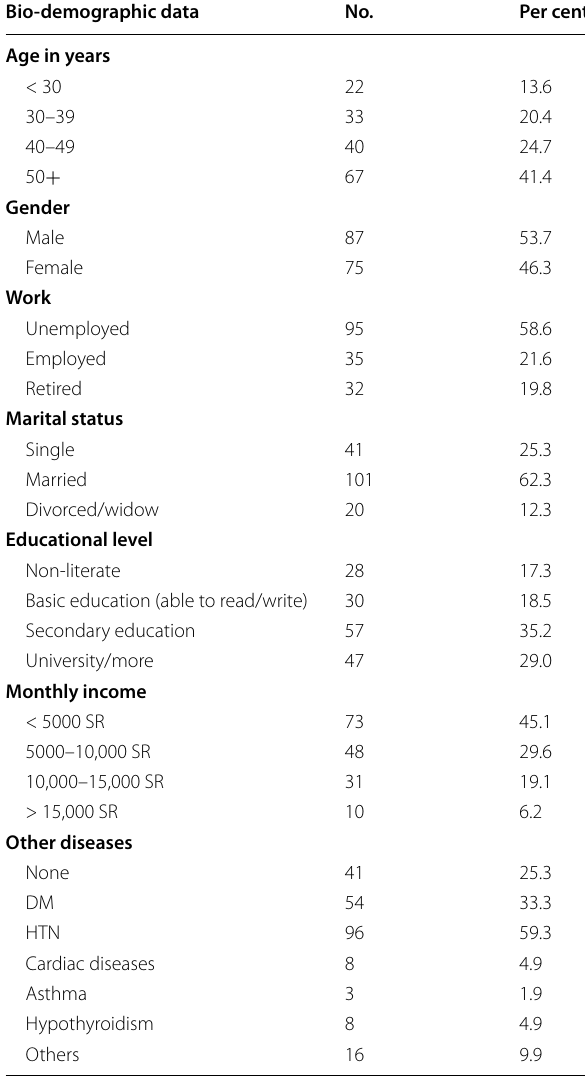
Table 1 Bio-demographic data of patients on haemodialysis, Saudi Arabia Bio-demographic